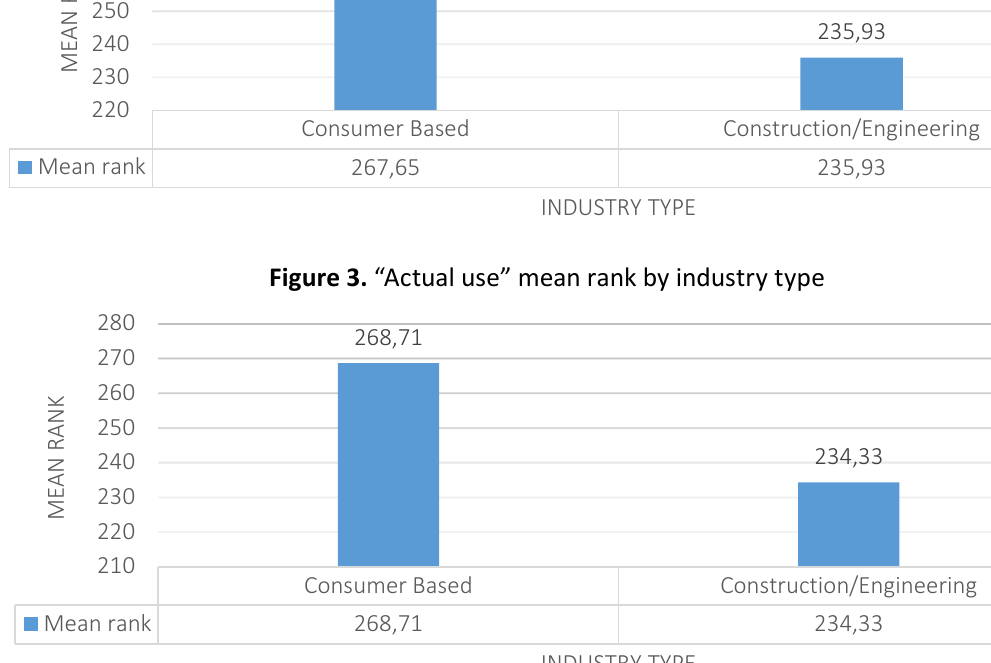
Figure 4. “Perceived usage” mean rank by industry